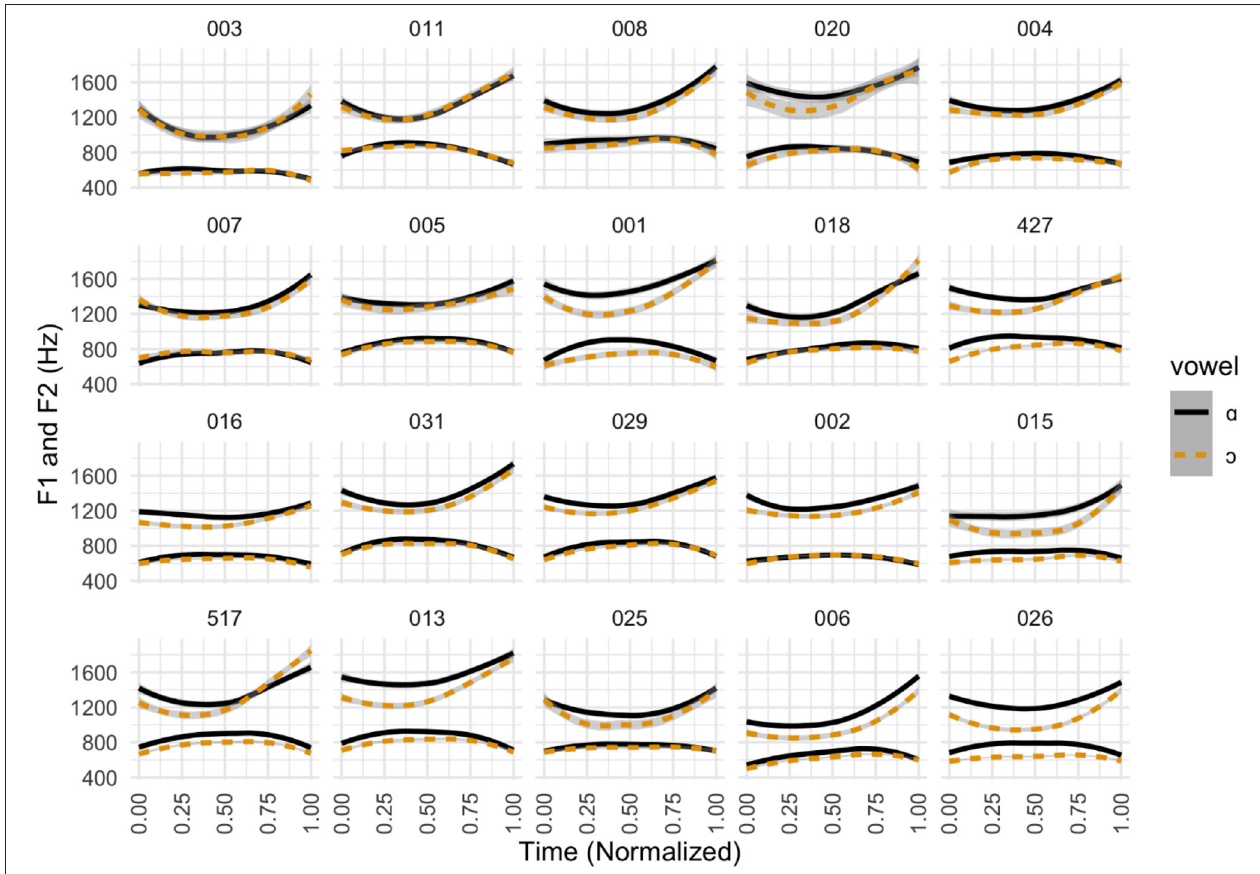
FIGURE 3 | Formant contours for cot-caught by participant. Individual time-normalized formant contours (F1 and F2) in Hz, separated by target phone. Participants are organized from lowest to highest Pillai score at 50% vowel